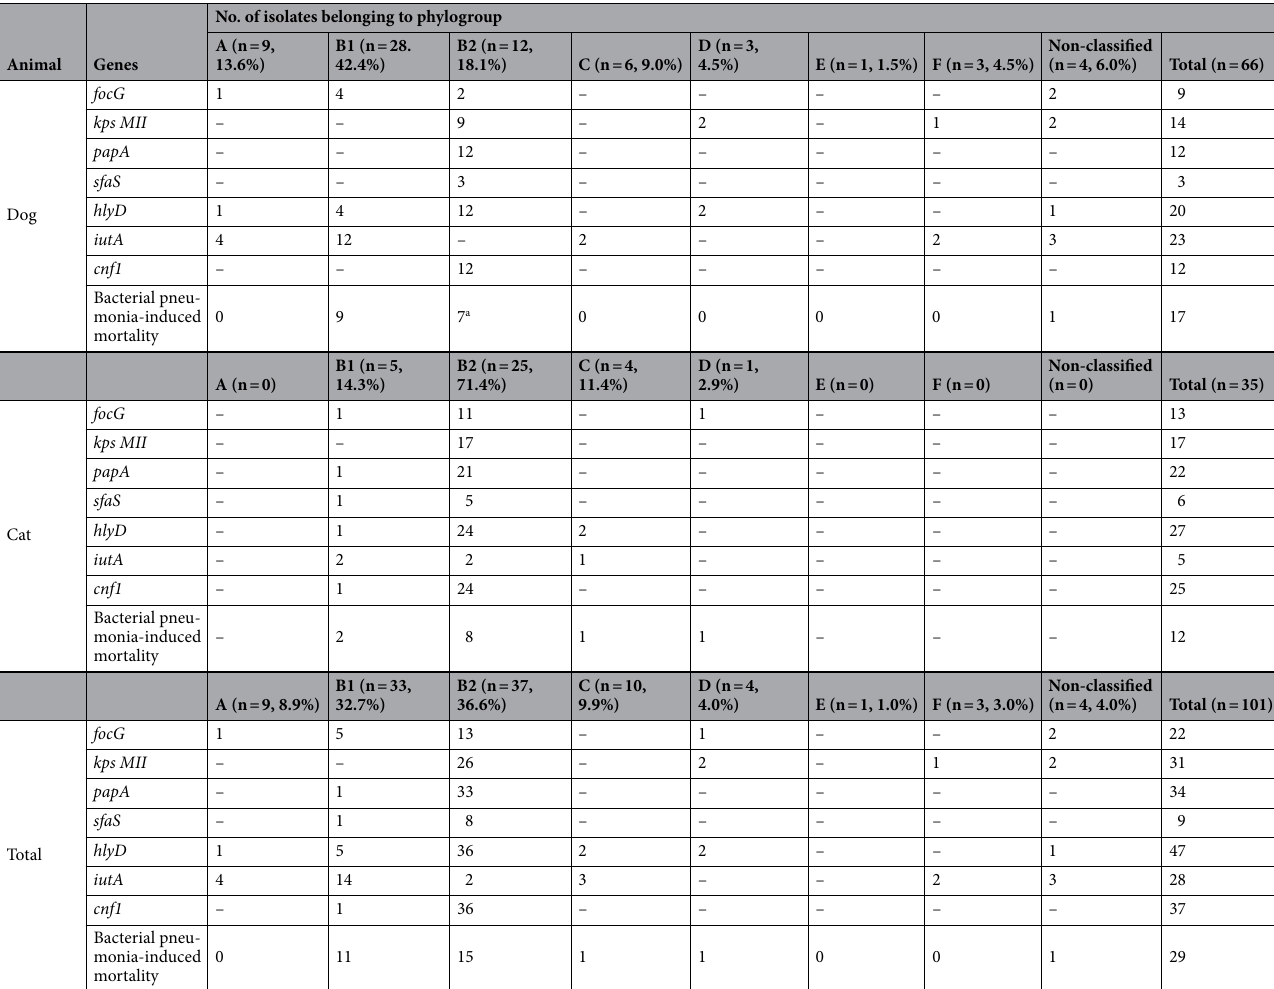
Table 3. Phylogroups and virulence factors in extraintestinal pathogenic E. coli isolates from the lung samples of dogs and cats. a Significant difference ( P < 0.05) between different phylogroups based on bacterial pneumonia-induced mortality in